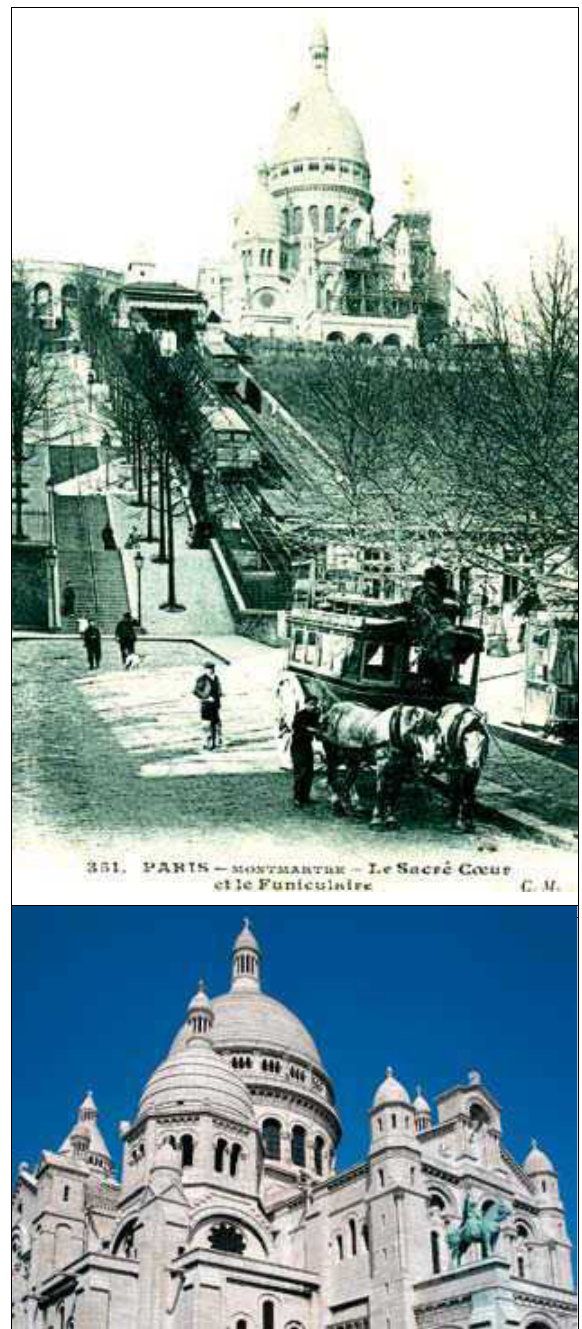
Fig. 2. basilica of the Sacred in Paris ( Sacre-Coeur ) (author’s